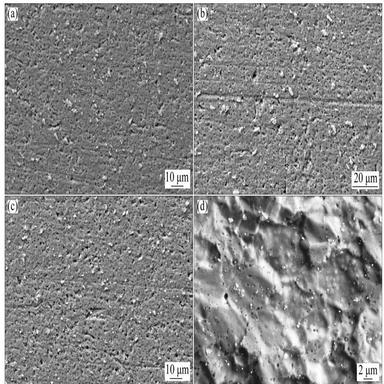
ESEM micrographs of AA2124/4wt.%B4C coatings on Ti−6Al−4V alloy at different rotational speeds: (a) 600 r/min; (b) 800 r/min; (c, d) 1000 r/min